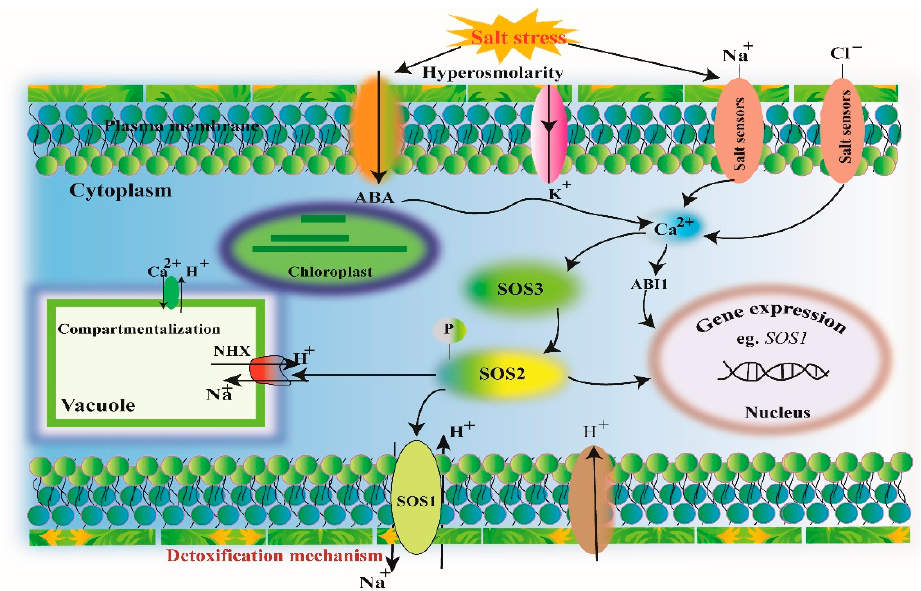
Figure 2. Schematic representation of the salt overly sensitive (SOS) pathway for salinity stress response. The SOS pathway regulates the Na + /H + antiporters. The SS-induced increase in Ca 2+ concentration in cytosol and is sensed by SOS3. SOS3 work together with SOS2 and triggers its kinase activity. The SOS2–SOS3 localized in plasma membrane. Then SOS2 phosphorylates SOS1 and triggers its antiporter (Na + /H + ) activity assisting Na + efflux from plant cell.